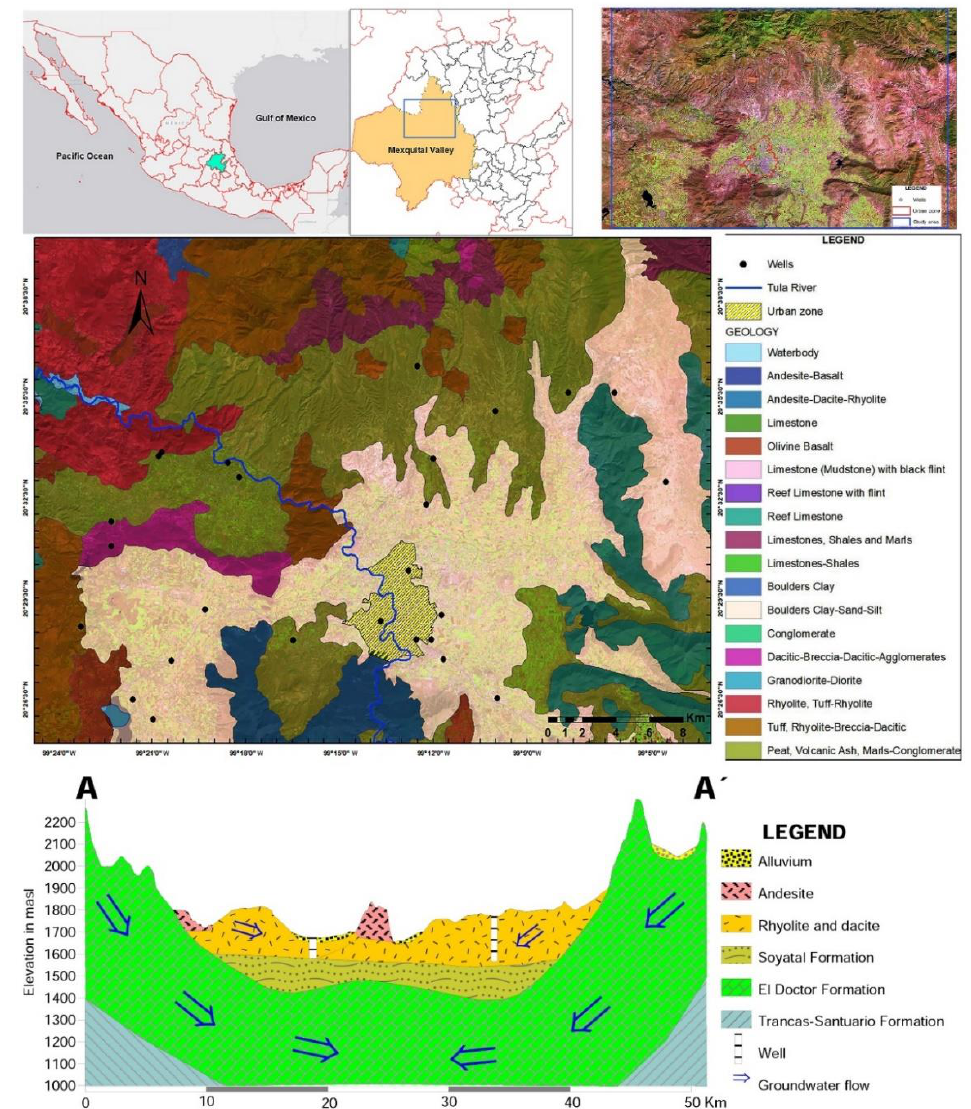
Figure 1. Location map of the study area, showing sampling locations, urban zones, agricultural areas, settlements, and the Tula River.